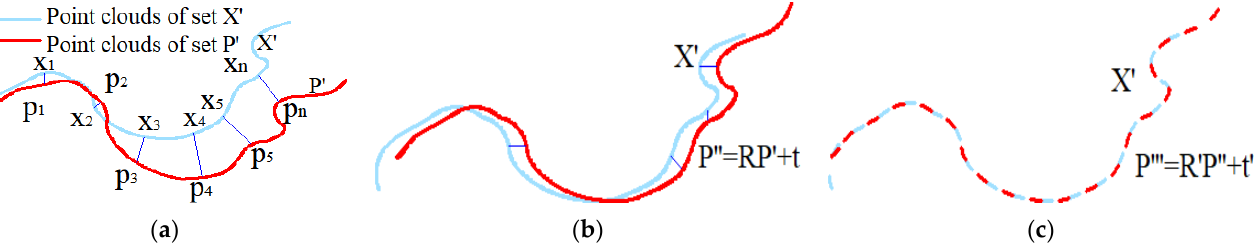
Figure 4. Schematic diagram of the ICP algorithm. ( a ) The closest point x n of point p n is regarded as the corresponding point of point p n . ( b ) Calculate the pose transformation and find new correspondences. ( c ) Calculate new pose transformation based on new correspondences.